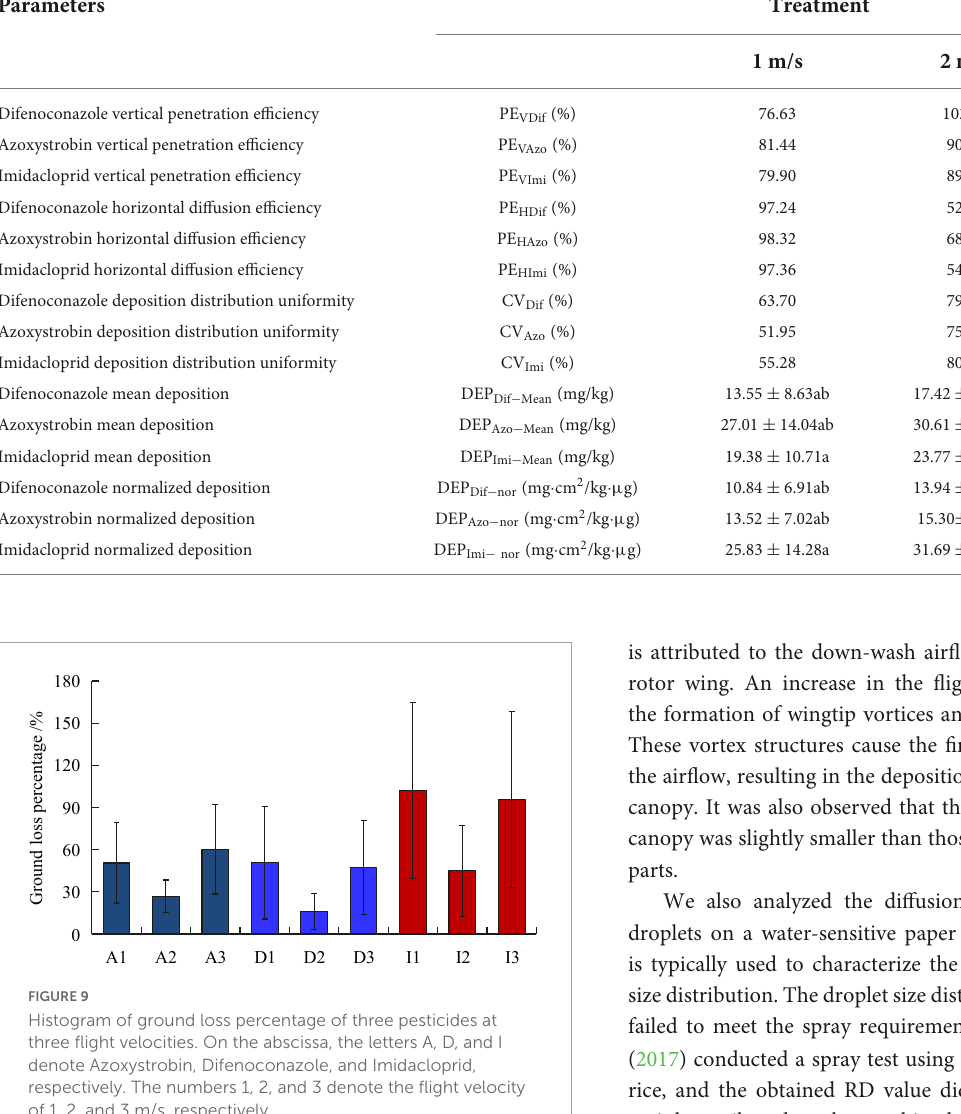
TABLE 3 Spray deposition distribution characteristics in canopy for the different flight velocities.